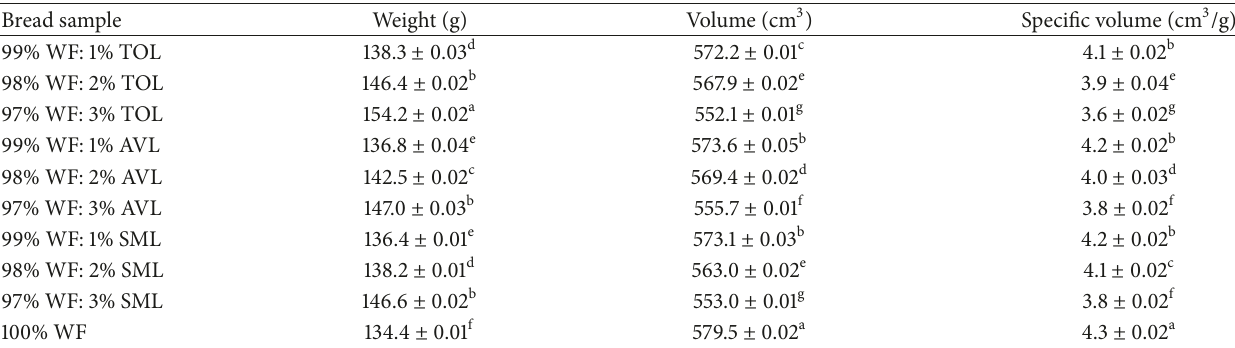
Table 5: Physical properties of wheat bread fortified with green leafy vegetable powders. Bread